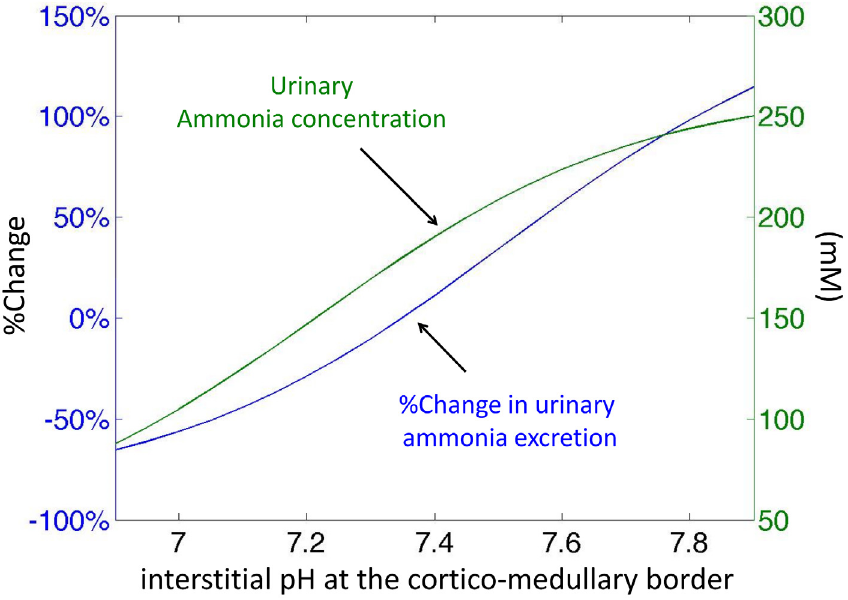
Fig 8. Impact of pH environment on urinary excretion of ammonia. The figure shows the percentage change in ammonia excretion rate and the urinary total ammonia concentration when the pH at the top of the interstitium is varied (thus changing the medullary pH